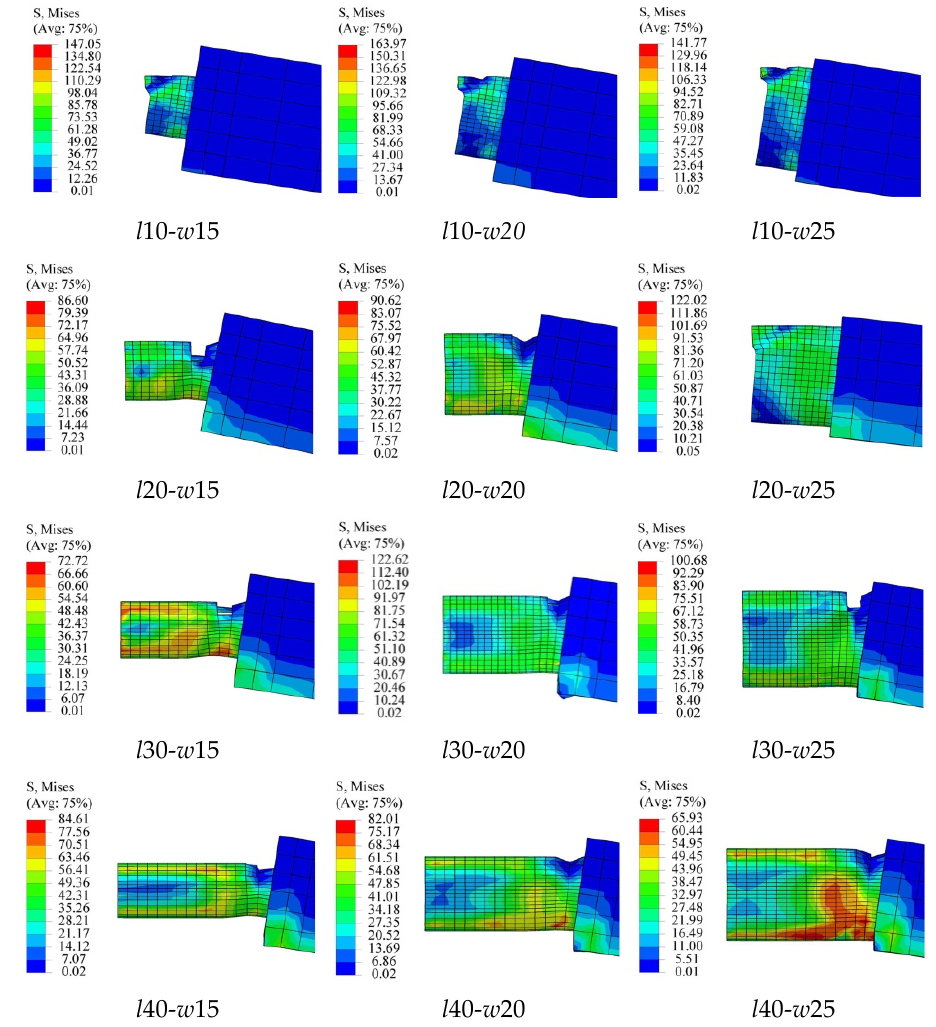
Figure 5. The failure modes of tenons with different sizes based on FEM. (unit MPa).